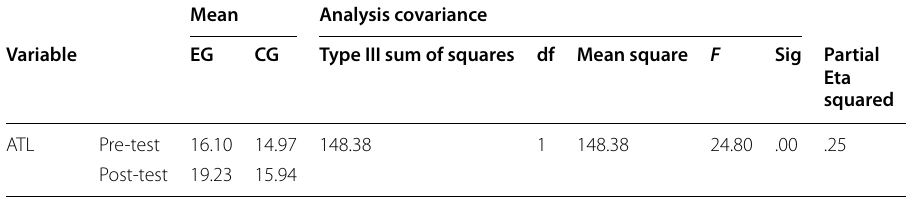
Table 6 Results of ANCOVA for ATL. Tests of between‑subjects effects